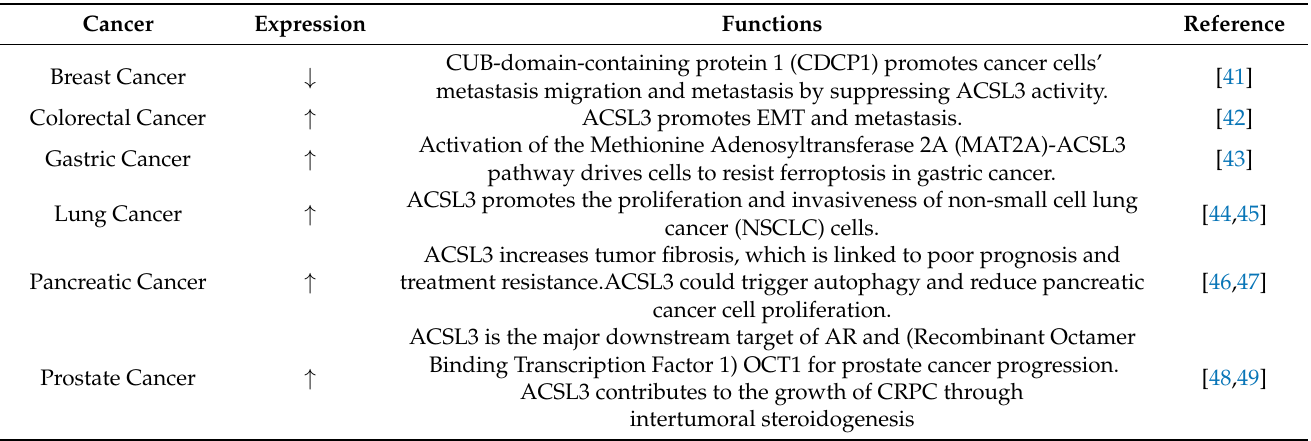
Table 1. ACSL3 in different cancers.